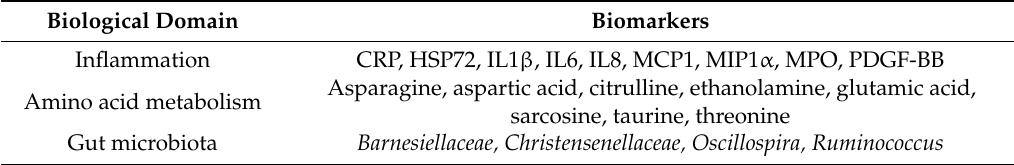
Table 1. Biological markers associated with PF&S operationalized, according to the Sarcopenia and Physical fRailty IN older people: multi-componenT Treatment strategies (SPRINTT) project’s